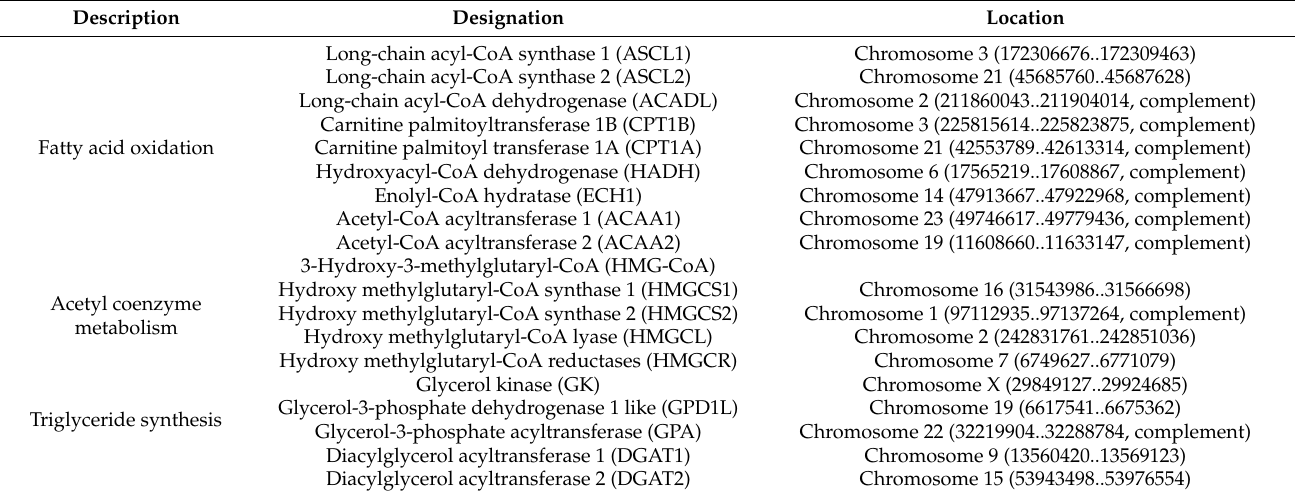
Table 1. Fatty acid metabolism-related